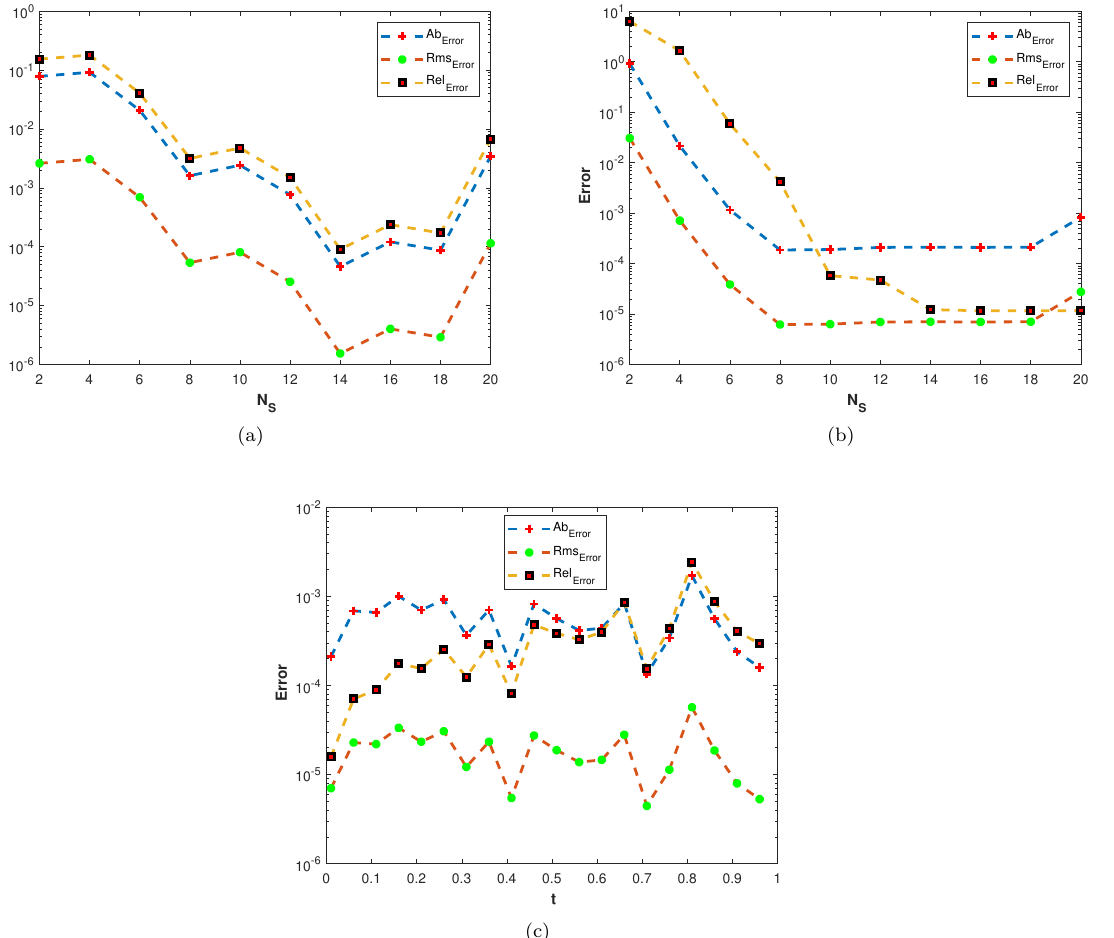
Figure 14: (a) Plots of Ab Error , Rms Error , and Rel Error versus N S at T = 1 . (b) Plots of Ab Error , Rms Error , Figure 14. ( a ) Plots of Ab Error , Rms Error , and Rel Error versus N S at T = 1. ( b ) Plots of Ab Error , Rms Error , and Rel Error versus N S with = 900 , σ n = 20 at T = 0 . 01 . (b) Plots of Ab Error , Rms Error , and Rel Error = 900, σ n = 20 at T = 0.01. ( c ) Plots of Ab Error , Rms Error , and Rel Error and Rel Error versus N S with G N G N versus N S versus t with = 900 , σ n = 20 , N S = 18. = 900, σ n = 20, N S = 18. versus N S versus t with G N G N